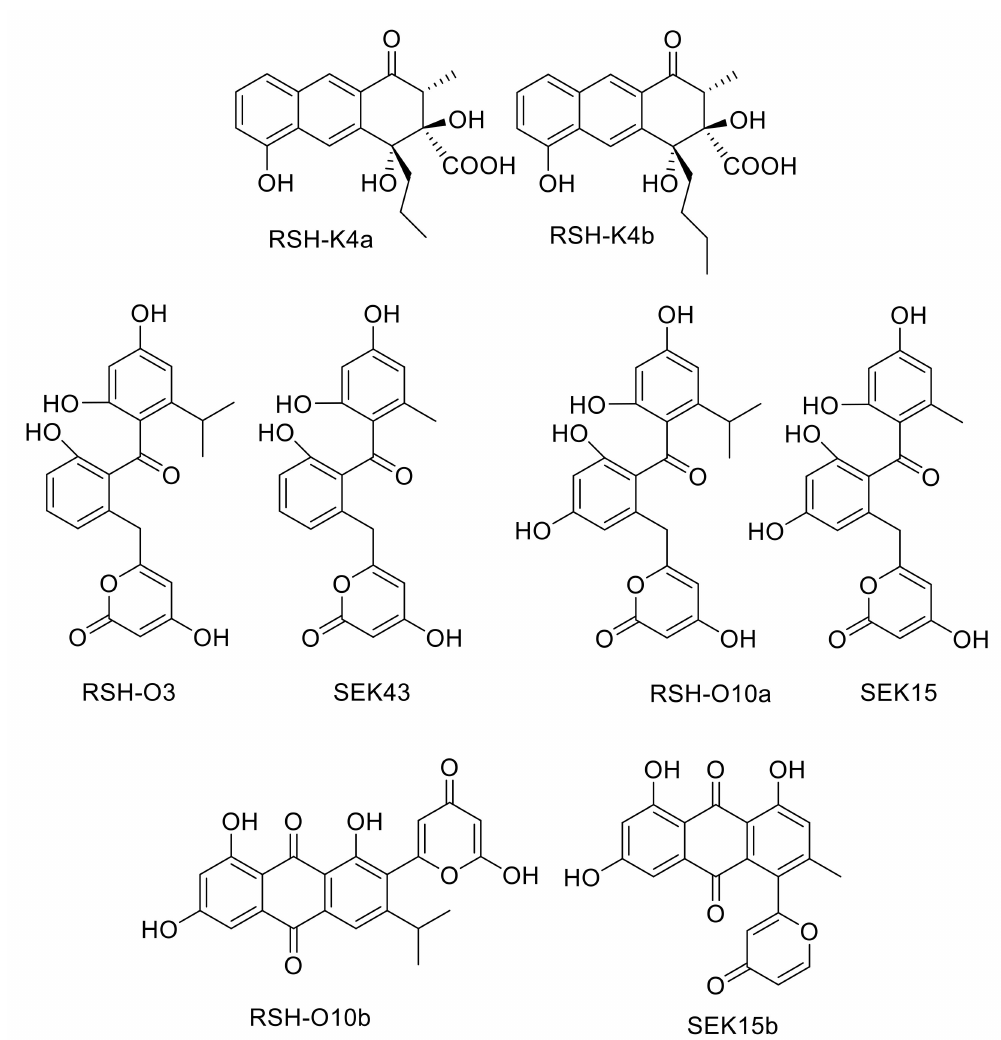
Figure 2. Compounds produced by strains generated during this study (RSH-K4a, putative structure of RSH-K4b, RSH-O3, RSH-O10a, RSH-O10b) and compounds known from the literature (SEK43, SEK15 and SEK15b